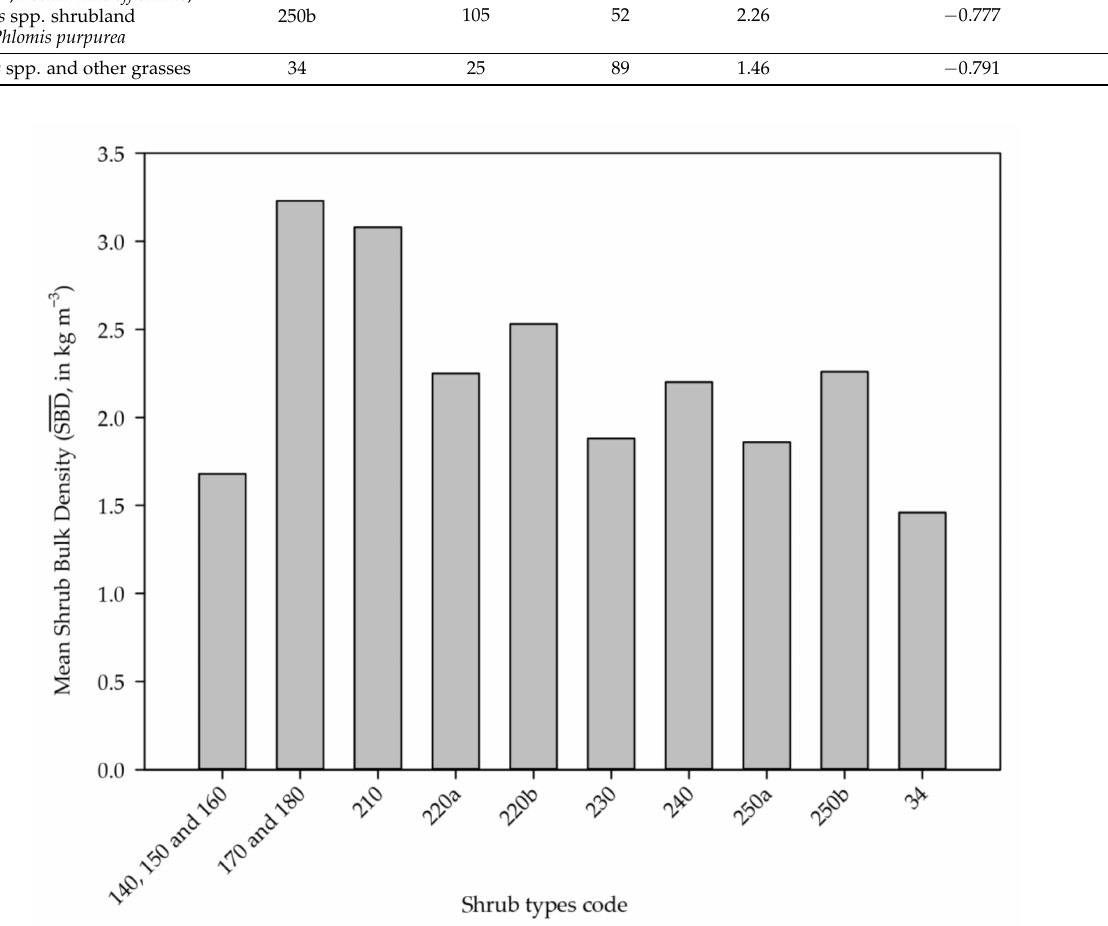
Figure 6. Mean Shrub Bulk Density ( SBD , in kg m − 3 ) for the 10 shrub types in the Iberian Peninsula. The numbers on the x-axis correspond to the codes of each shrub type (140, 150, 160 = Machias, terebinthus, garrigues; 170, 180 = Quercus coccifera and Pistacia lentiscus ; 210 = Heathers, Ericaceae shrubs and related groups; 220a = Small size Cistaceae shrubs; 220b = Big size Cistaceae shrubs; 230 = Mixture of broom leguminous shrubs; 240 = Ulex spp. shrubs and related groups; 250a = Rosmarinus officinalis ; 250 = Lavandula spp., Rosmarinus officinalis , Thymus spp. shrubland and Phlomis purpurea ; 34 = Ampelodesmos spp. and other